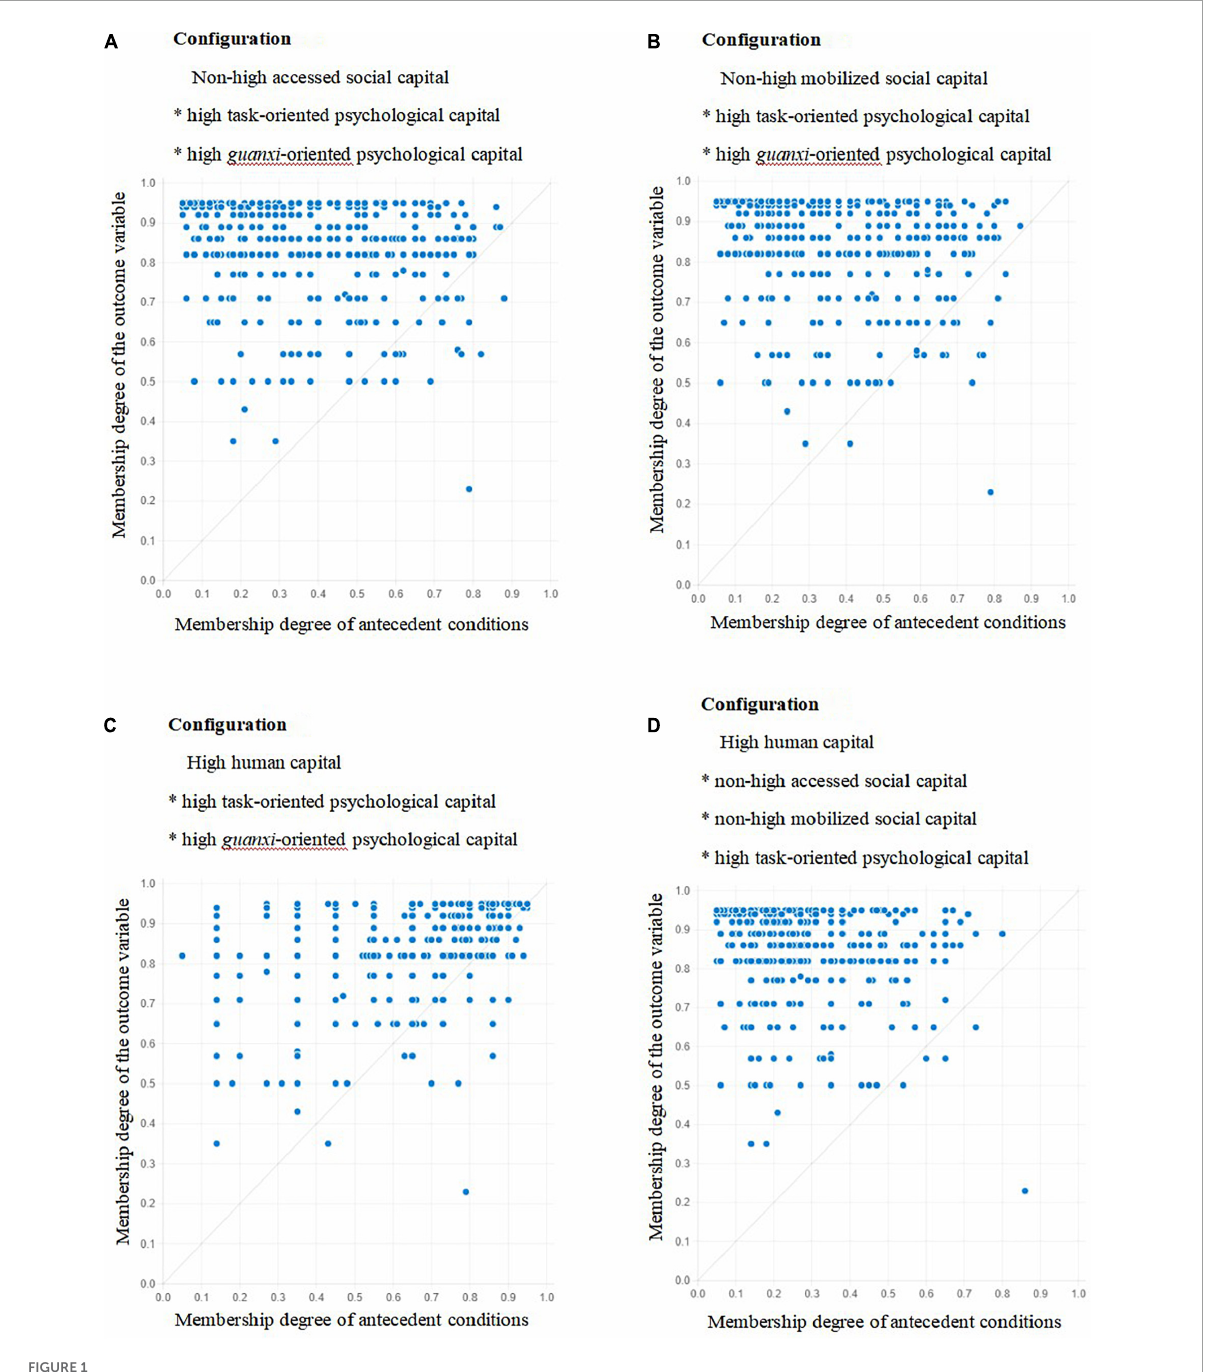
FIGURE1 Fuzzy subset relation diagrams for Configurations A–D , and task performance.